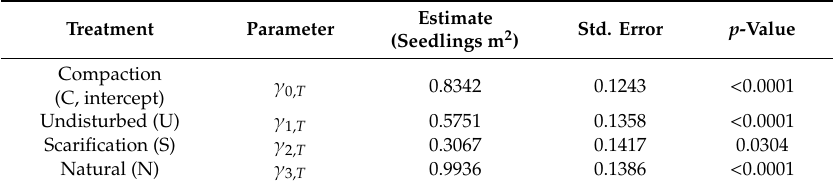
Table 4. Parameter values of Equation (2) (count part of the zero-inflated model), estimates, standard errors and p -values to estimate the number of recruits (treatment e ff ect) in Spanish black pine forests subjected to treatments in Cuenca Mountains